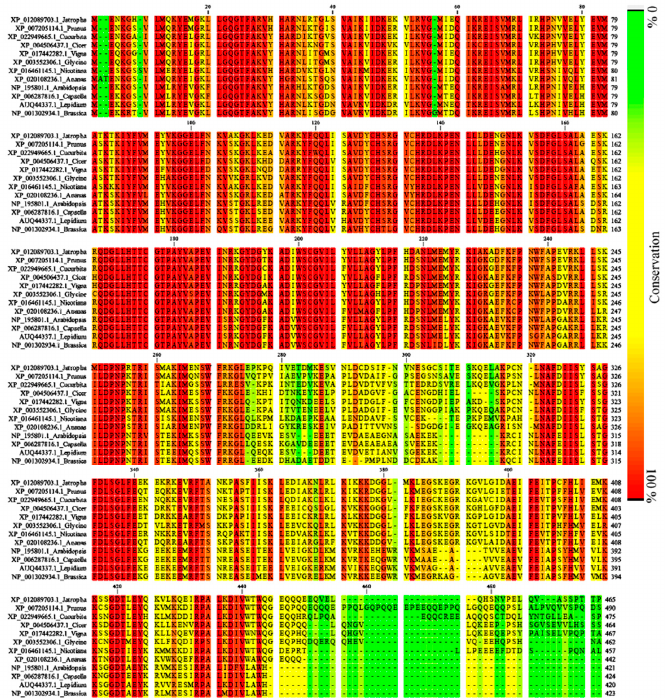
Figure 2. Alignment of deduced amino acid sequence of Lla CIPK (AUQ44337) protein with other CIPK proteins from different genera.